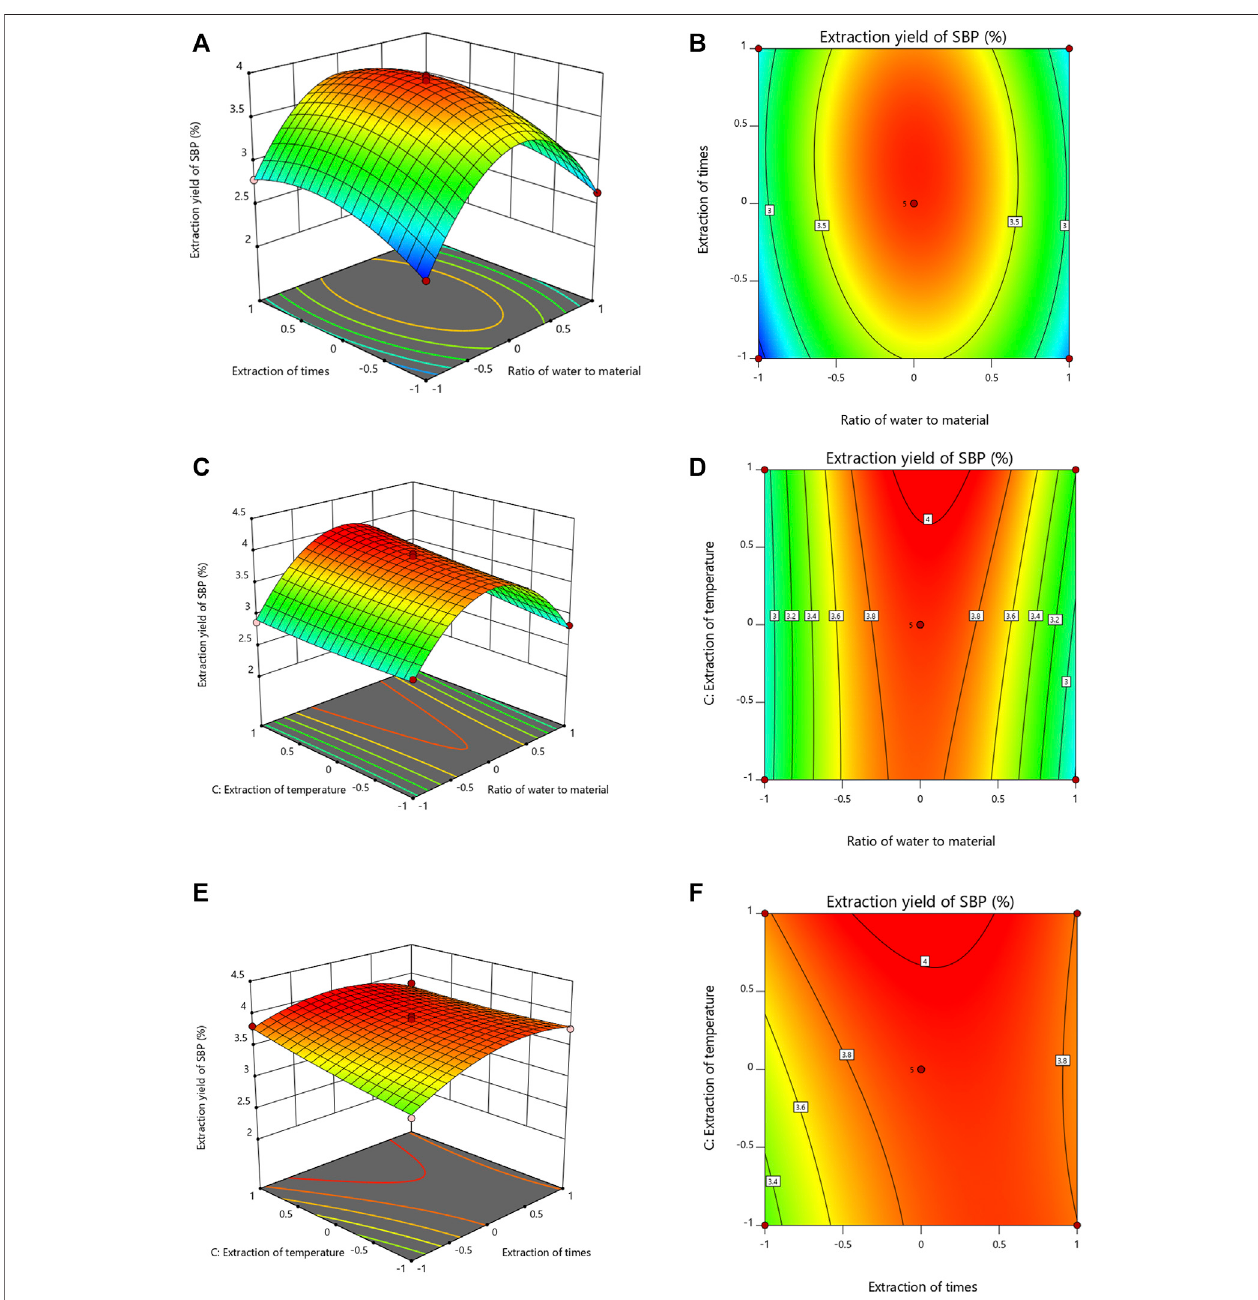
FIGURE2| Responsesurfaceandcontourmapofthethree-factorinteractionintheSBPextractionrate. (A – F) showingtheeffectsofextractiontime,ratioofwater to material and extraction temperature on the extraction yields of SBP.